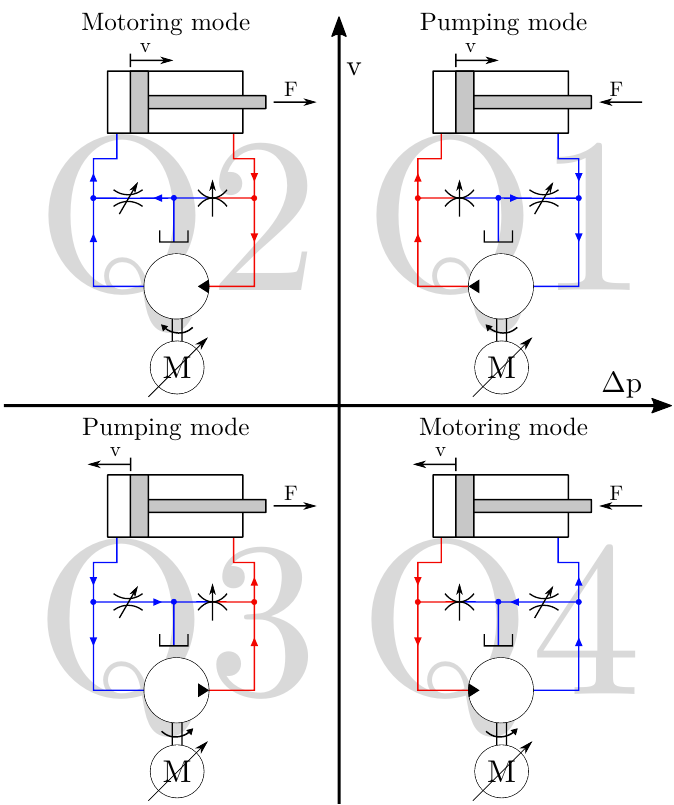
Figure 2. Working modes for a generalised closed circuit architecture.